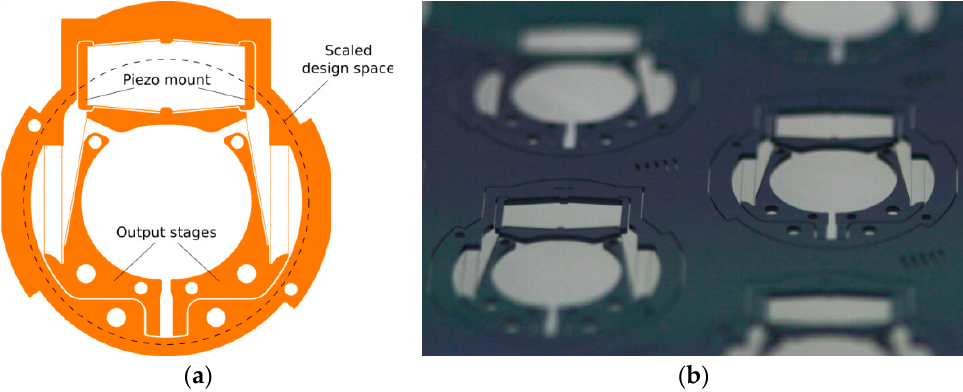
Figure 4. Design of the amplification linkage ( a ) and realized silicon linkages manufactured by DRIE ( b ).